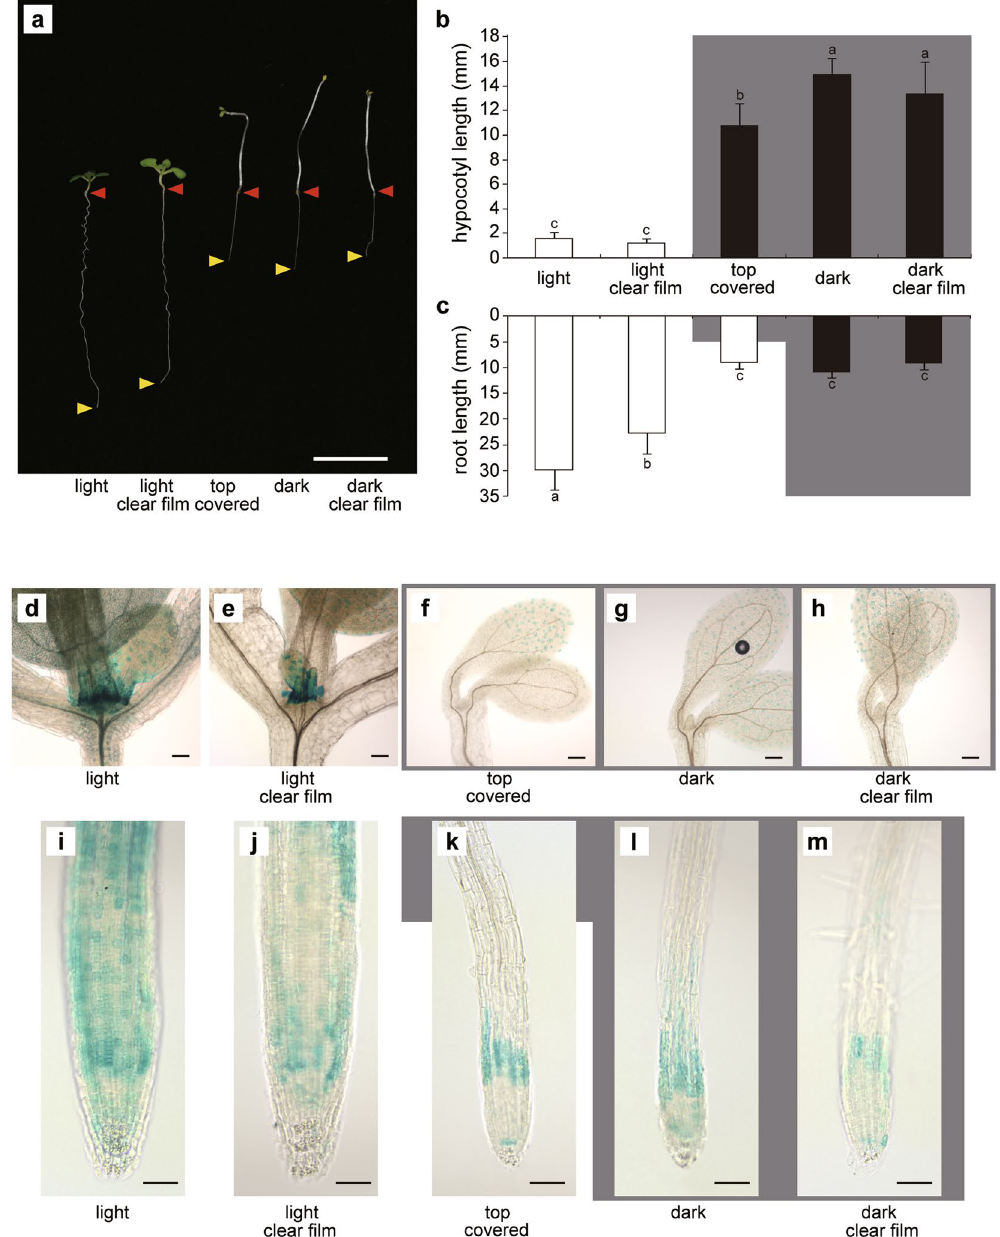
Figure 5. Top half covered growth (TCG) test results revealed that light perception in roots did not promote DWF4 expression in the root apex. ( a ) Root elongation. Red arrowheads indicate the junctions between the hypocotyl and root, while yellow arrowheads indicate the root apex positions. Hypocotyl ( b ) and root ( c ) lengths according to the TCG test. The grey background indicates which part was darkened [n = 32]. Means denoted by the same letter are not significantly different (P < 0.05) according to the Tukey–Kramer method. DWF4-GUS expression around the shoot apical meristem ( d – h ) and in the root apex ( i – m ). Light conditions with no film ( d , i ) or with a clear film ( e , j ). Shoots in darkness covered with a black film and roots under light ( f , k ). Although the root apex was exposed to light, the GUS signal in the root meristem was weaker than that of plants that were incubated entirely under light. Dark conditions with no film ( g , l ) or with a clear film ( h , m ). Bars represent 10 mm ( a ) and 50 µ m ( d – m ). Error bars represent standard